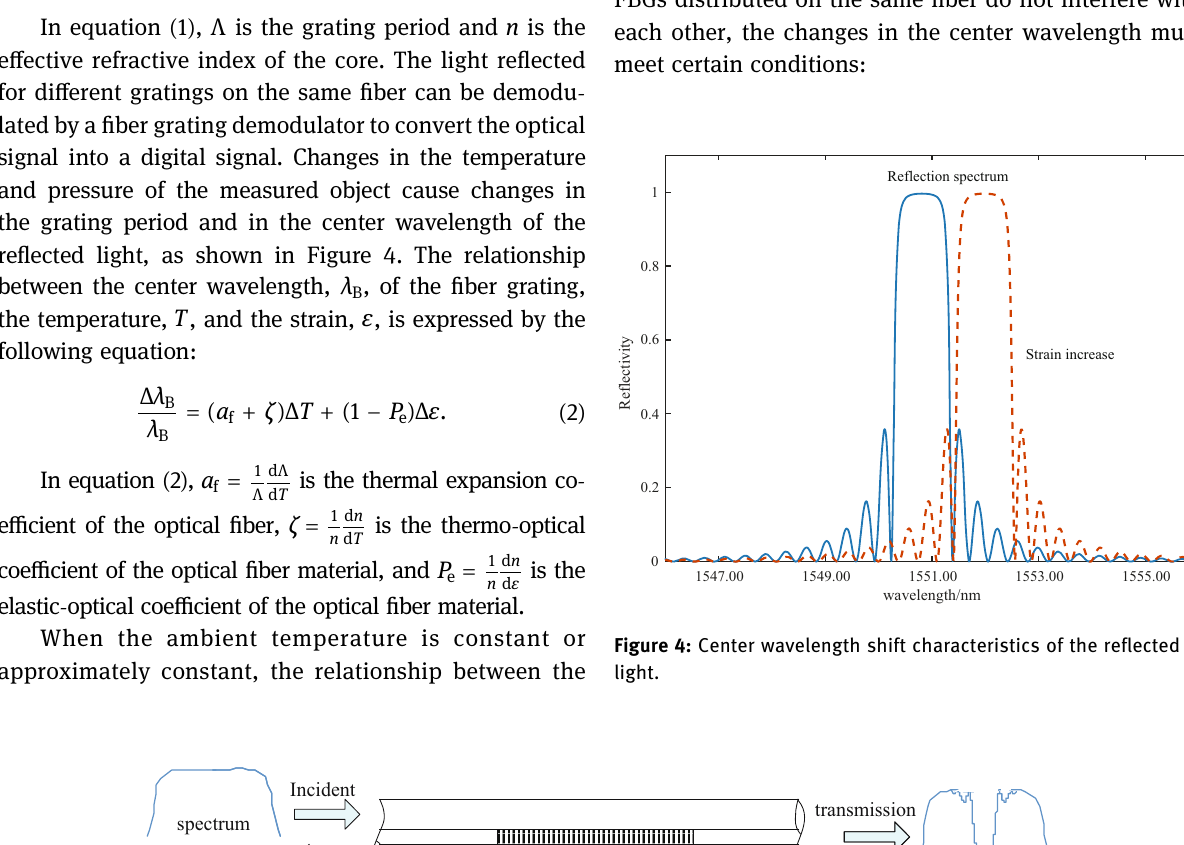
Combined with the structural characteristics of a water - lubricated bearing, the FBGs can be implanted into the rubber matrix along the axis of the rubber stave. The radial loads are monitored by multi - point measure - ments of the axial strain in the rubber stave, as shown in Figure 5. To ensure that the center wavelengths of the FBGs distributed on the same fi ber do not interfere with each other, the changes in the center wavelength must meet certain conditions: